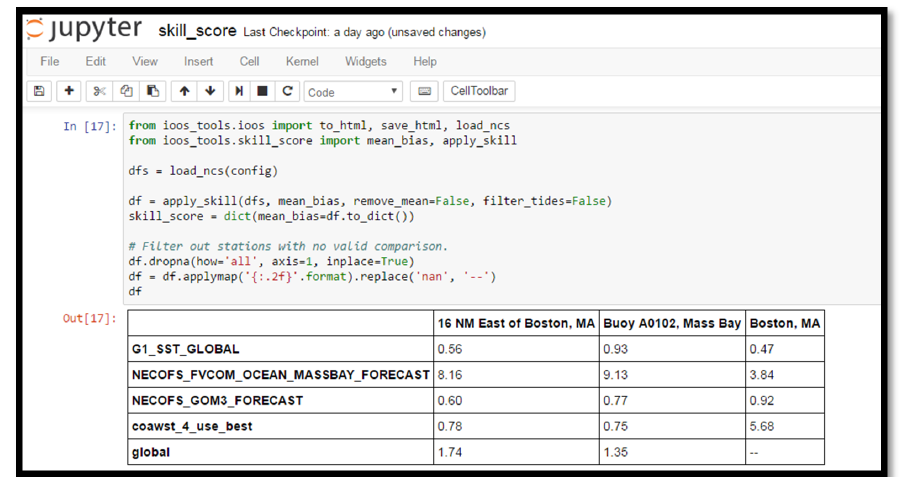
Figure 6. Screenshot from a section of the Skill Score notebook, illustrating the computation of skill score metrics using pandas data frames. Here we see the mean bias calculation, with the results showing significant bias in the NECOFS MassBay Forecast at all locations, and in the COAWST model forecast in Boston Harbor.